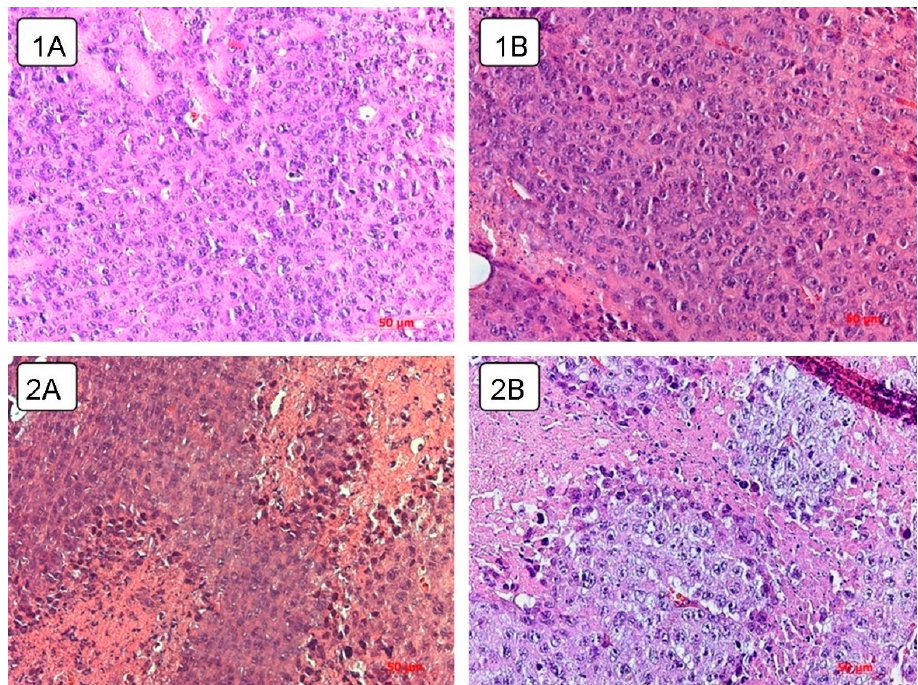
Figure 7. Necrotic changes in a Krebs-2 solid tumor node. 1A, B—necrotic areas in the tumor tissue of mice without virotherapy on ( 1A ) day 5 (day 13 of tumor growth), ( 1B ) day 20 (day 28 of tumor growth), hematoxylin-eosin staining, 40x magnification. 2A, B—necrotic areas in the tumor tissue of mice on ( 2A ) day 5 after virotherapy (day 13 of tumor growth), ( 2B ) day 20 after virotherapy (day 28 of tumor growth), hematoxylin-eosin staining, 40 × magnification. Live virus injections triggered necrotic processes on day 5, which occupied 16.7 ± Table 1. Volume density of necrosis and marker expression in Krebs-2 carcinoma during the experi-